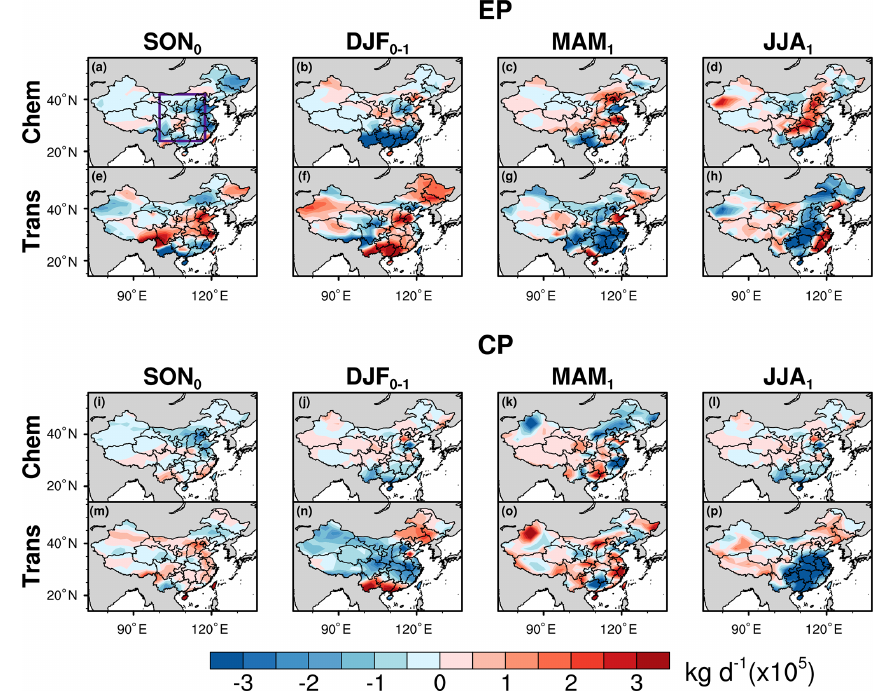
Figure 6. The tropospheric column ozone mass anomalies of chemistry and transport processes (0–6km; in kgd − 1 ) driven by composite meteorological fields for four seasons in EP and CP El Niño